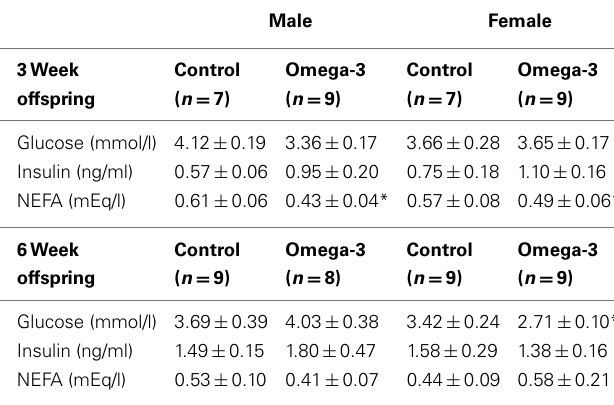
Table 4 | Plasma glucose, insulin, and NEFA concentrations at 3 and 6weeks of age in offspring of Control and Omega-3 dams.